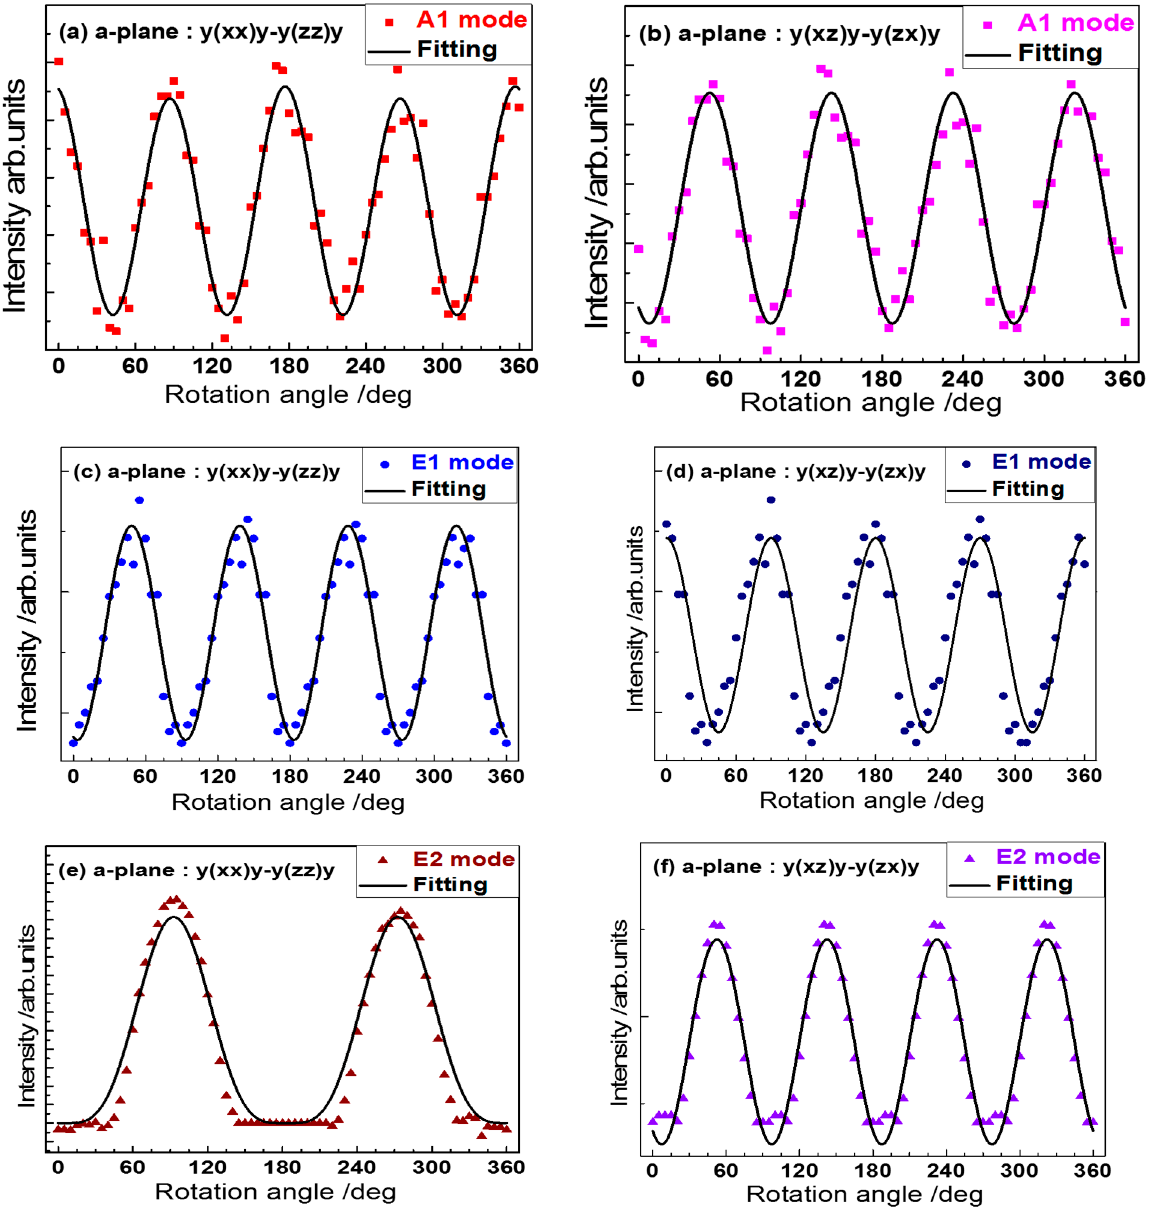
Figure 4. ( a , b ) The angle-dependent intensity of the A 1 signal from the a-plane surface of the SiC sample for parallel and perpendicular polarization vectors of incoming laser and the scattered light. ( c , d ) The intensity of the E 1 signal from the a-plane surface versus the rotation angle for parallel and perpendicular polarization vectors, respectively. ( e , f ) The intensity of the E 2 mode signal versus the rotation angle for parallel and perpendicular